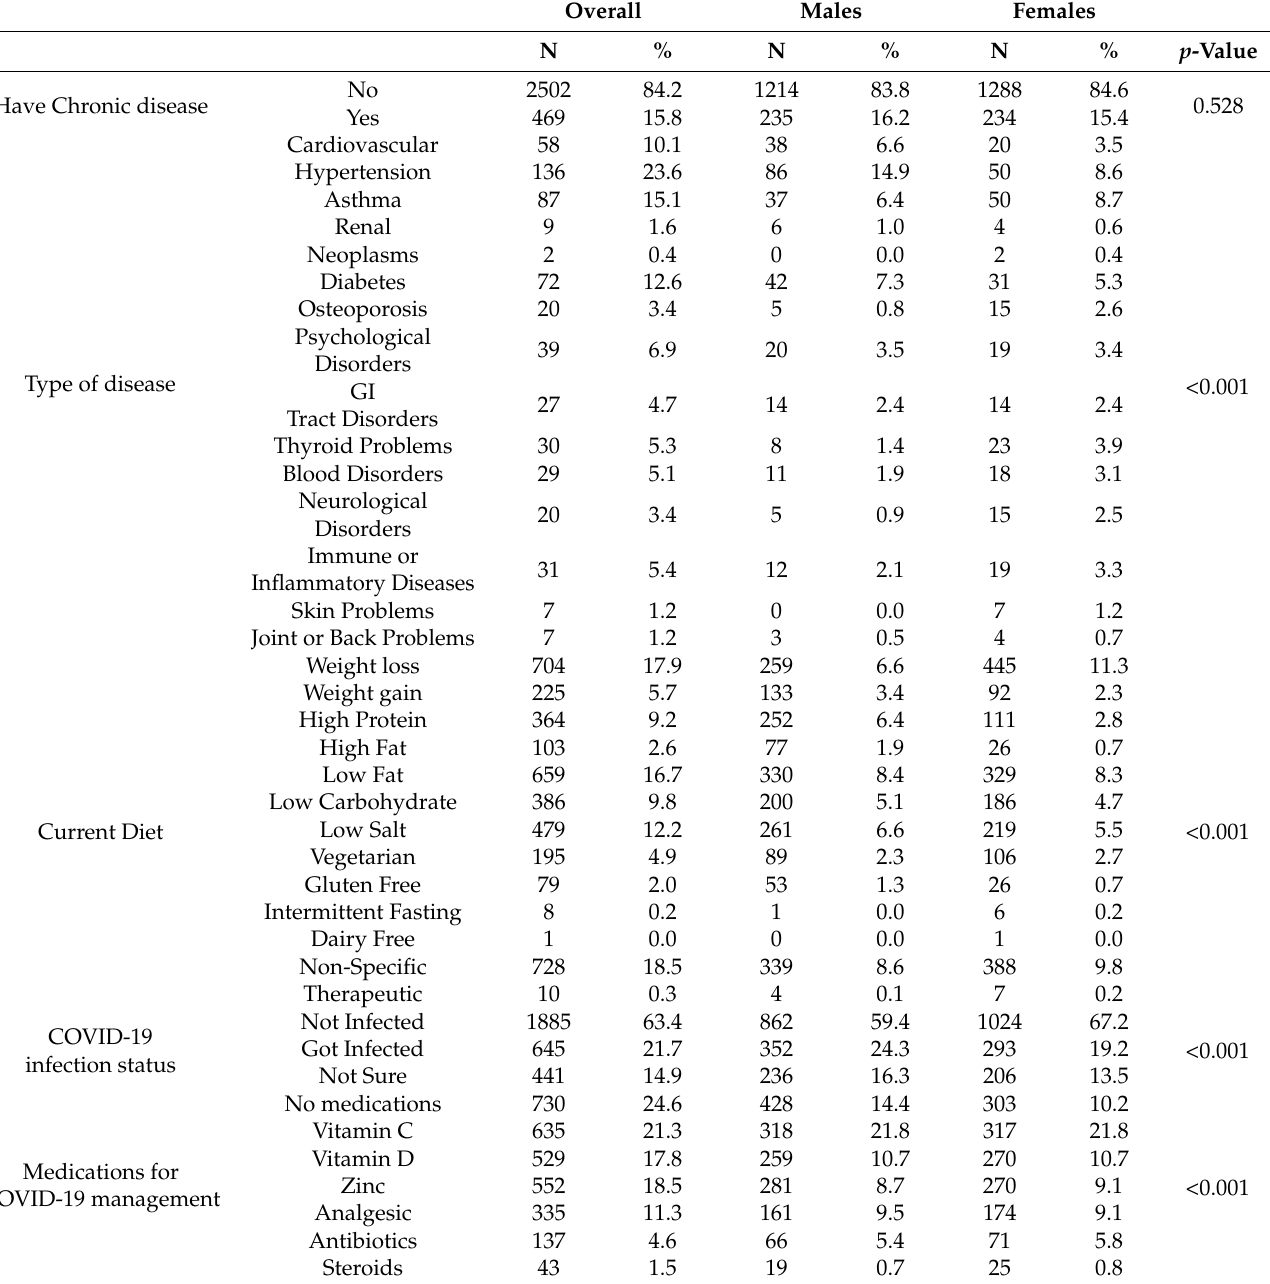
Table 2. Health and COVID-19 infection status of the study participants, overall and by gender. Overall Males Females N